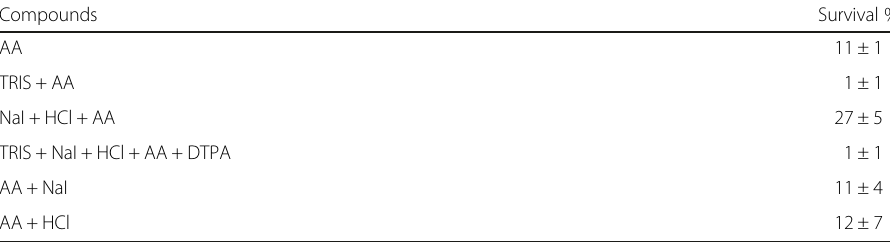
Table 3 CA20948 clonogenic survival in mean percentage ± SD after exposure to ascorbic acid or in combination with TRIS, NaI, HCl and DTPA, n = 3. Concentration in incubation medium was; [TRIS] = 16 mmol.L − 1 , [AA] = ascorbic acid, 3.4 mmol.L − 1 , [NaI] = 3.6 mmol.L − 1 , [HCl] = 3.6 mmol.L −